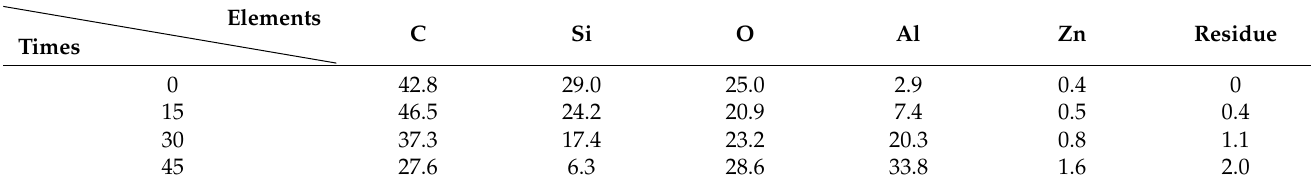
Table 2. Variation in the elemental contents of SLIPS after different icing/deicing cycles.